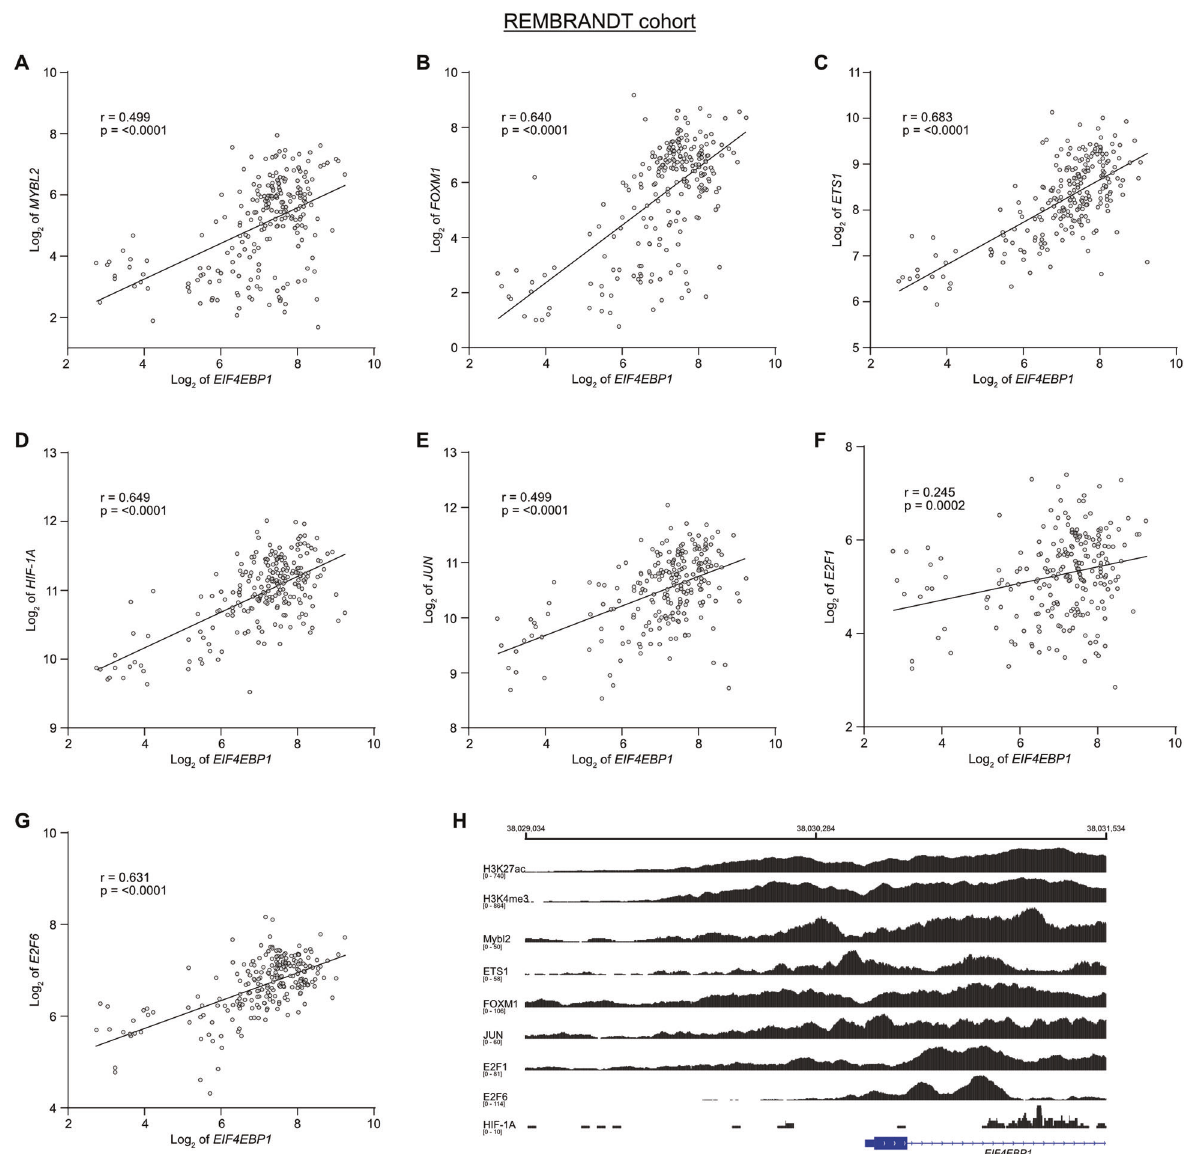
Fig. 2 Co-expression of EIF4EBP1 and EIF4EBP1 promoter binding transcription factor genes in glioblastoma tissue samples. A – G Expression levels of EIF4EBP1 mRNA in glioblastoma patient samples plotted against the mRNA expression levels of ( A ) MYBL2 , ( B ) FOXM1 , ( C ) ETS1 , ( D ) HIF-1A , ( E ) JUN , ( F ) E2F1 or ( G ) E2F6 in the REMBRANDT cohort ( n = 228 patients) [26]. Co-expression levels were quanti fi ed by calculating the Pearson correlation coef fi cient. H ChIP peak locations within the human EIF4EBP1 promoter, exon 1 and part of intron 1 ( − 1500 to + 1000; hg38; Chr8: 38,029,034 – 38,031,534) from ChIP-sequencing data for histone H3K27 acetylation (H3K27ac) and H3K4 trimethylation (H3K4me3), ETS1, FOXM1, JUN, E2F1, and E2F6 (Encode consortium, Encyclopedia of DNA Elements at UCSC; [41, 42]), HIF-1A (accession code GSE39089; name GSM955978; run SRR518265 [43]) and MYBL2 (accession code GSE119972; name GSM3389599 [44]). 4EBP1 activation in poorly vascularized areas [48]. We searched for represent a more general regulatory mechanism driving EIF4EBP1 the underlying causes of increased EIF4EBP1 mRNA expression in expression in different cancer entities. malignant gliomas and observed that the EIF4EBP1 gene is not ampli fi ed in glioblastomas although ampli fi cation of 8p11.23, which encompasses EIF4EBP1 , has been reported in other cancer DISCUSSION entities, such as lung squamous cell carcinoma, bladder cancer, EIF4EBP1 gene expression and its clinical relevance in cancer are and breast cancer, and correlated with higher EIF4EBP1 expression highly tumor-type speci fi c [47]. We found that EIF4EBP1 is [49]. By bioinformatic analysis, we identi fi ed seven transcription overexpressed in glioblastoma tissue samples in different patient factors that may potentially drive overexpression of EIF4EBP1 in cohorts as compared to non-neoplastic brain tissues, thus gliomas. Each of these transcription factors harbors oncogenic or extending previous observations made in the TCGA cohort [12]. tumor-promoting functions and some of them were reported to Elevated mRNA expression may lead to increased active 4EBP1 be overexpressed in cancer, including overexpression of E2F1 , protein levels in glioblastoma, as it was reported that mTOR E2F6 [40], FOXM1 , and MYBL2 [50] in glioblastomas. Among the activity is reduced regionally in this tumor entity, thus leading to